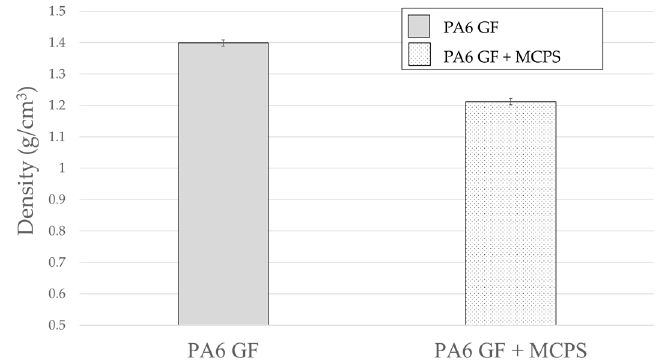
Figure 16. Effect of MCPs on density.